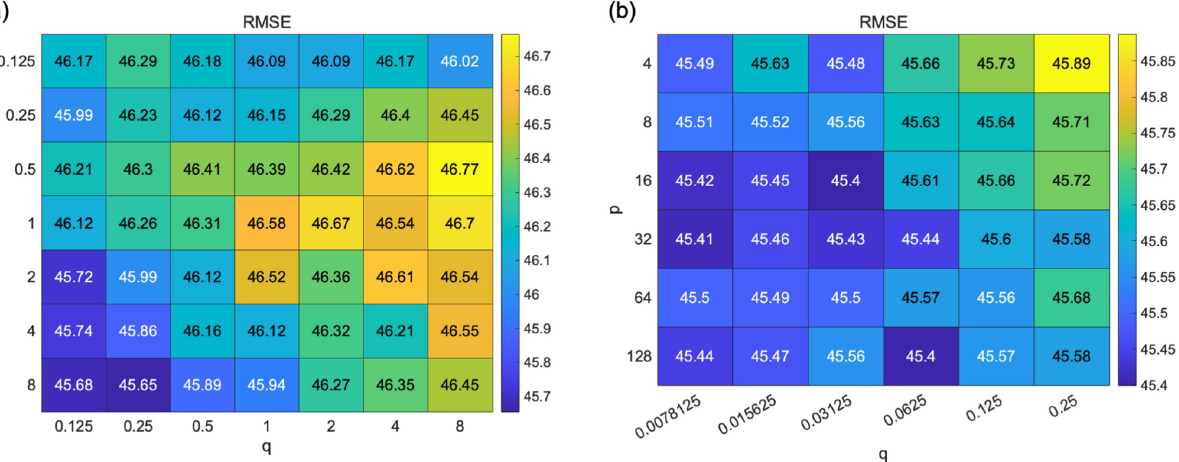
Fig 8. Result of grid search of hyperparameters p and q of node2vec. (a) p , q 2 {1/8, 1/4, 1/2, 1, 2, 4, 8}, the number of iteration = 100. (b) p 2 {4, 8, 16, 32, 64, 128} and q 2 {1/128, 1/64, 1/32, 1/16, 1/8, 1/4}, the number of iteration = 300. Here, we set ( t , l , w , d ) = (7, 60, 13, 75), as determined by the pre-analysis. We evaluated the regression performance with the changes in parameters p and q using the root mean squared error (RMSE). Although the variation in RMSE with the change in parameters is not large, the regression performance tends to improve when p is large, and q is small. However, there is little change in RMSE in the range when p is sufficiently large and q is sufficiently